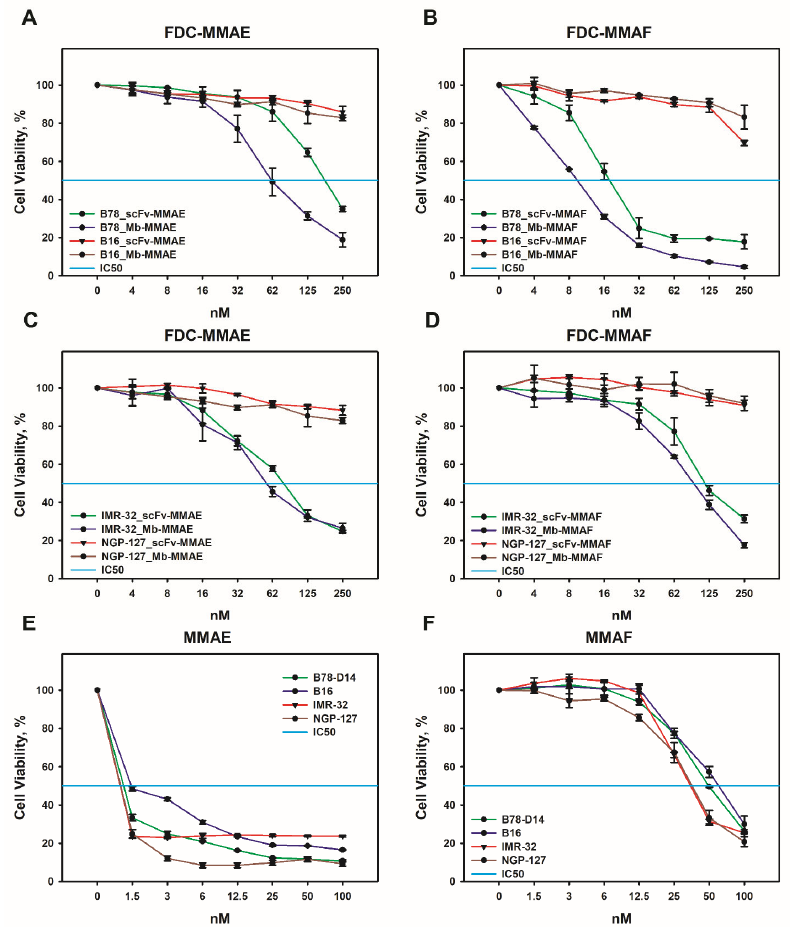
Figure 4. Cytotoxic activity of anti ‐ GD2 FDCs in GD2 ‐ positive (B78 ‐ D14 and IMR ‐ 32) and GD2 ‐ negative (B16 and NGP ‐ 127) cell lines. Viability of cell lines analyzed by MTT assay following 72 h incubation with scFv ‐ MMAE and minibody ‐ MMAE ( A , C ) , scFv ‐ MMAF and minibody ‐ MMAF ( B , D ), MMAE ( E ), or MMAF ( F ). scFv–scFv fragments 14.18, Mb–minibodies 14.18. GD2 is a recognized marker of neuroblastoma [18], so two human neuroblastoma cell lines, namely, GD2 ‐ negative NGP ‐ 127 and GD2 ‐ positive IMR ‐ 32, have been used to demonstrate FDC antitumor effects in this type of cancer. As we have previously shown, IMR ‐ 32 cells express GD2 at a high level, but significantly lower than B78 ‐ D14 cells, while NGP ‐ 127 cells do not express the marker [7,19]. The inhibitory effects of FDCs in the IMR ‐ 32 cell line were also significant in the MTT assay. However, FDCs based both on scFv fragments and minibodies were more effective in eliminating IMR ‐ 32 cells when they con ‐ tained MMAE, in contrast to FDCs with MMAF which demonstrated a more prominent activity in B78 ‐ D14 cells (Figure 4C,D). For IMR ‐ 32 cells, the IC50 of scFv ‐ MMAE and minibody ‐ MMAE were 81.1 ± 5 nM and 56.5 ± 4 nM, respectively, and the IC50 of scFv ‐ MMAF and minibody ‐ MMAF were 116.7 ± 8 nM and 98.3 ± 6 nM, respectively. As with the case of GD2 ‐ negative mouse melanoma B16, cells of the GD2 ‐ negative human neuro ‐ blastoma NGP ‐ 127 were insensitive to the obtained FDCs even at high concentrations (Figure 4C,D). At the same time, free drugs did not demonstrate selective activity against GD2 ‐ positive and GD2 ‐ negative tumor cell lines; the IC50 of MMAE for all cell lines was roughly the same, approx. 1–1.5 nM (Figure 4E). Human neuroblastoma cell lines ap ‐ peared to be somewhat more sensitive to MMAF (IC50 range 35–38 nM) compared to